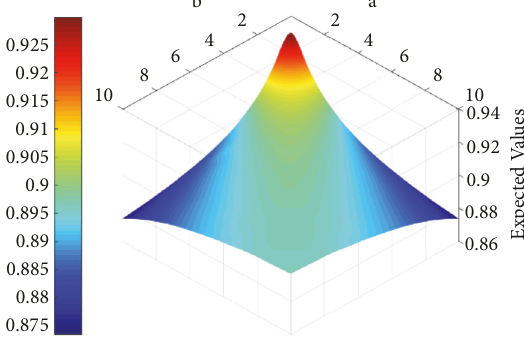
̃̃1) Figure 4: 𝐷(𝑅 2 − of Α 2 based on IT2FWPHM operator.